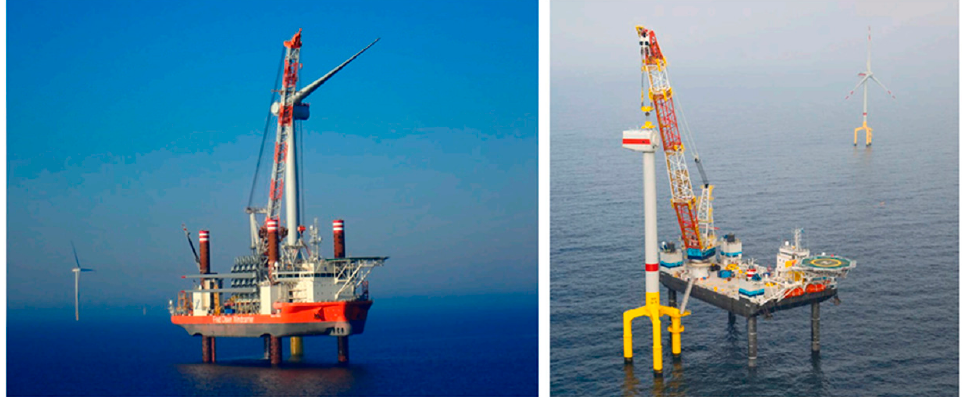
Figure 2. Self-elevating and floating operation and maintenance platform [12].